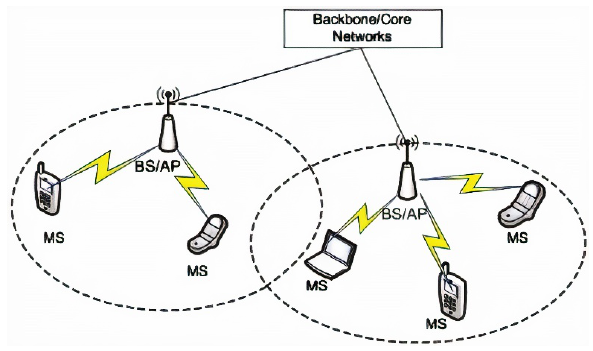
Figure 1. Cognitive Radio fundamental block